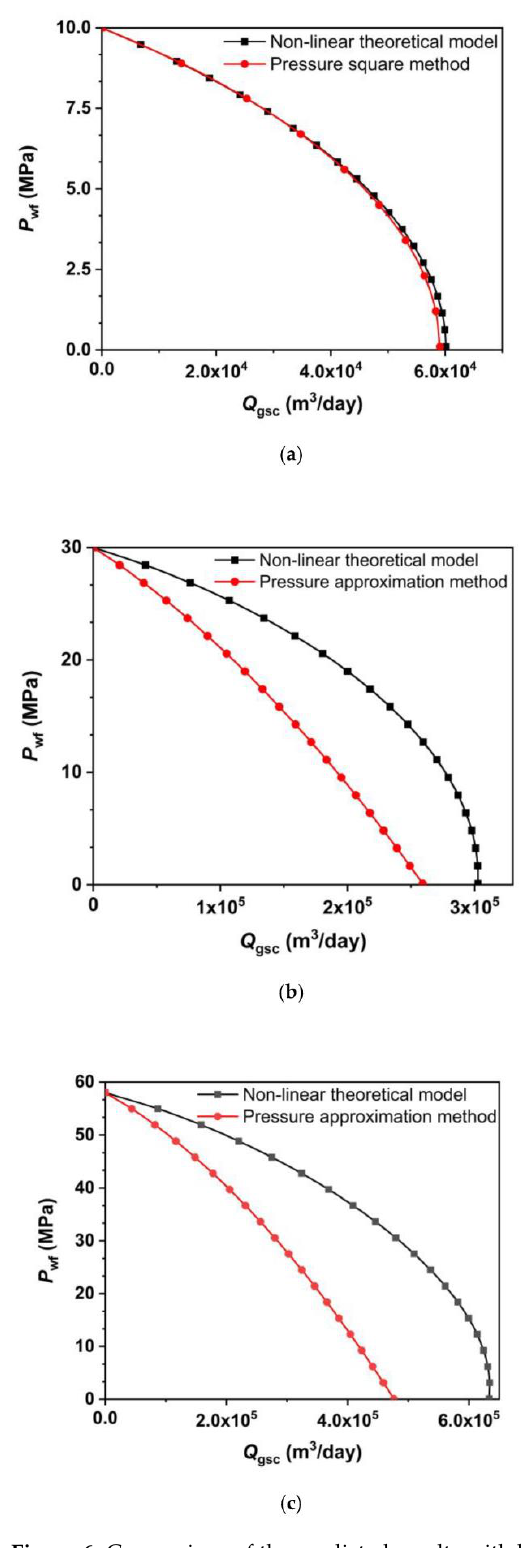
Figure 6. Comparison of the predicted results with linearization methods at three different pressure conditions: ( a ) IPR curves made by non-linear theoretical model and pressure square method within the well bottom hole pressure of 0.1–10 MPa, ( b ) IPR curves made by non-linear theoretical model and pressure approximation method within the well bottom hole pressure of 0.1–30 MPa ( c ) IPR curves made by non-linear theoretical model and pressure approximation method within the well bottom hole pressure of 0.1–58